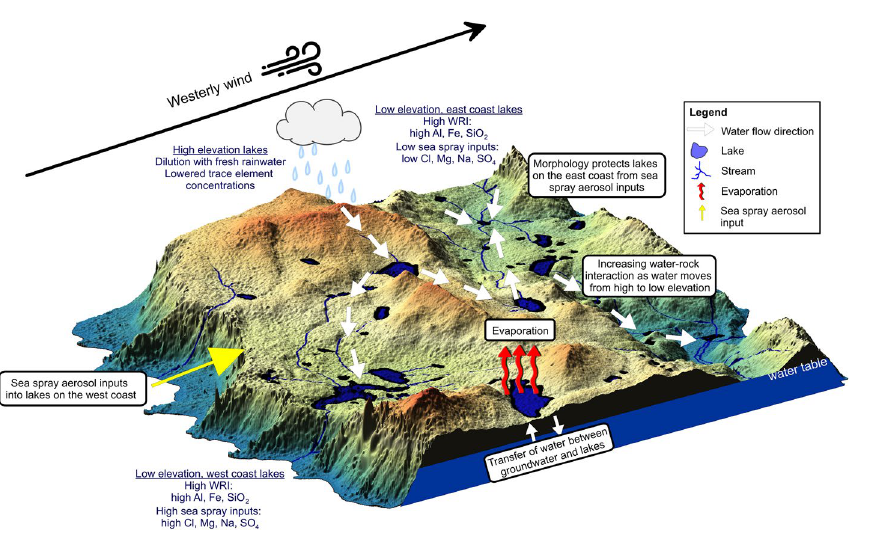
Figure 7. Conceptual synthesis of the hydrochemical processes affecting lake water chemistry on Macquarie